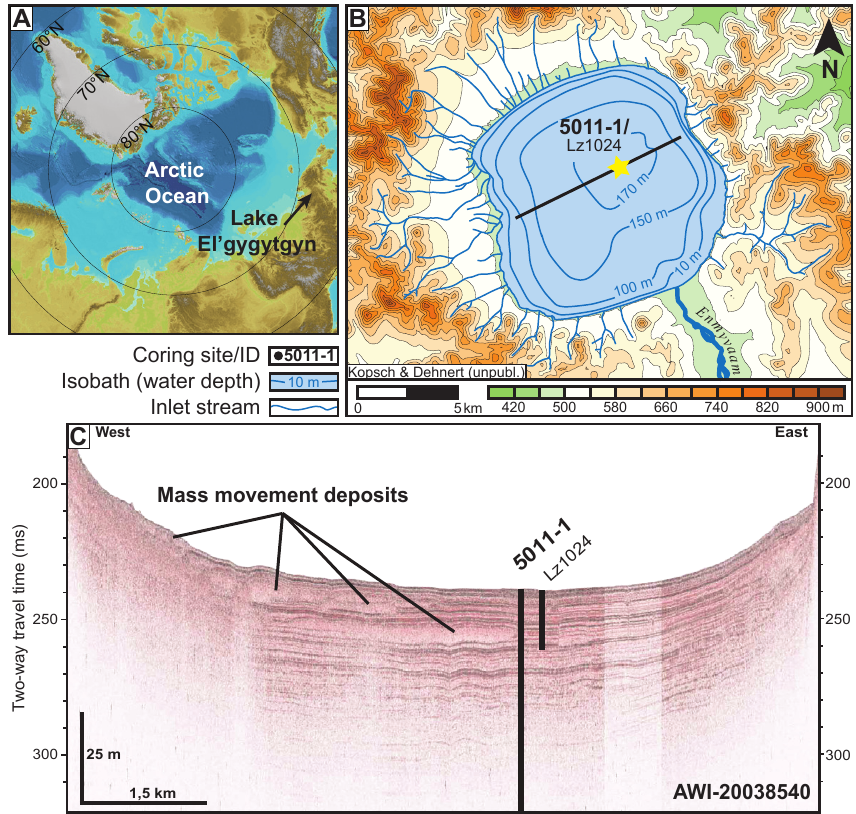
Fig. 1. (A) Location of Lake El’gygytgyn in northeastern Russia. (B) Position of the drill site 5011-1, pilot core Lz1024 and seismic profile (black line) AWI-20038540. Digital elevation model is after Kopsch (2005) and lake bathymetry after Belyi (2001). (C) Sediment echosounder profile AWI-20038540 (3.5kHz) in a WSW–ENE direction crossing the coring site and showing multiple mass movement deposits (MMDs) as acoustically transparent units on the western slope and lake